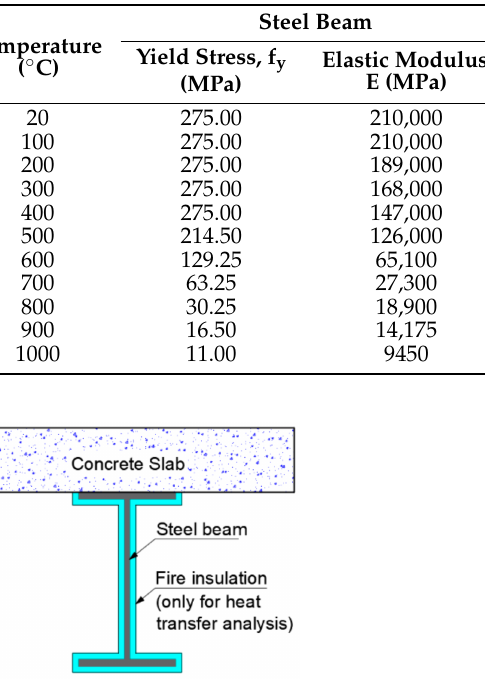
Figure 10. Protected steel beam using insulation.